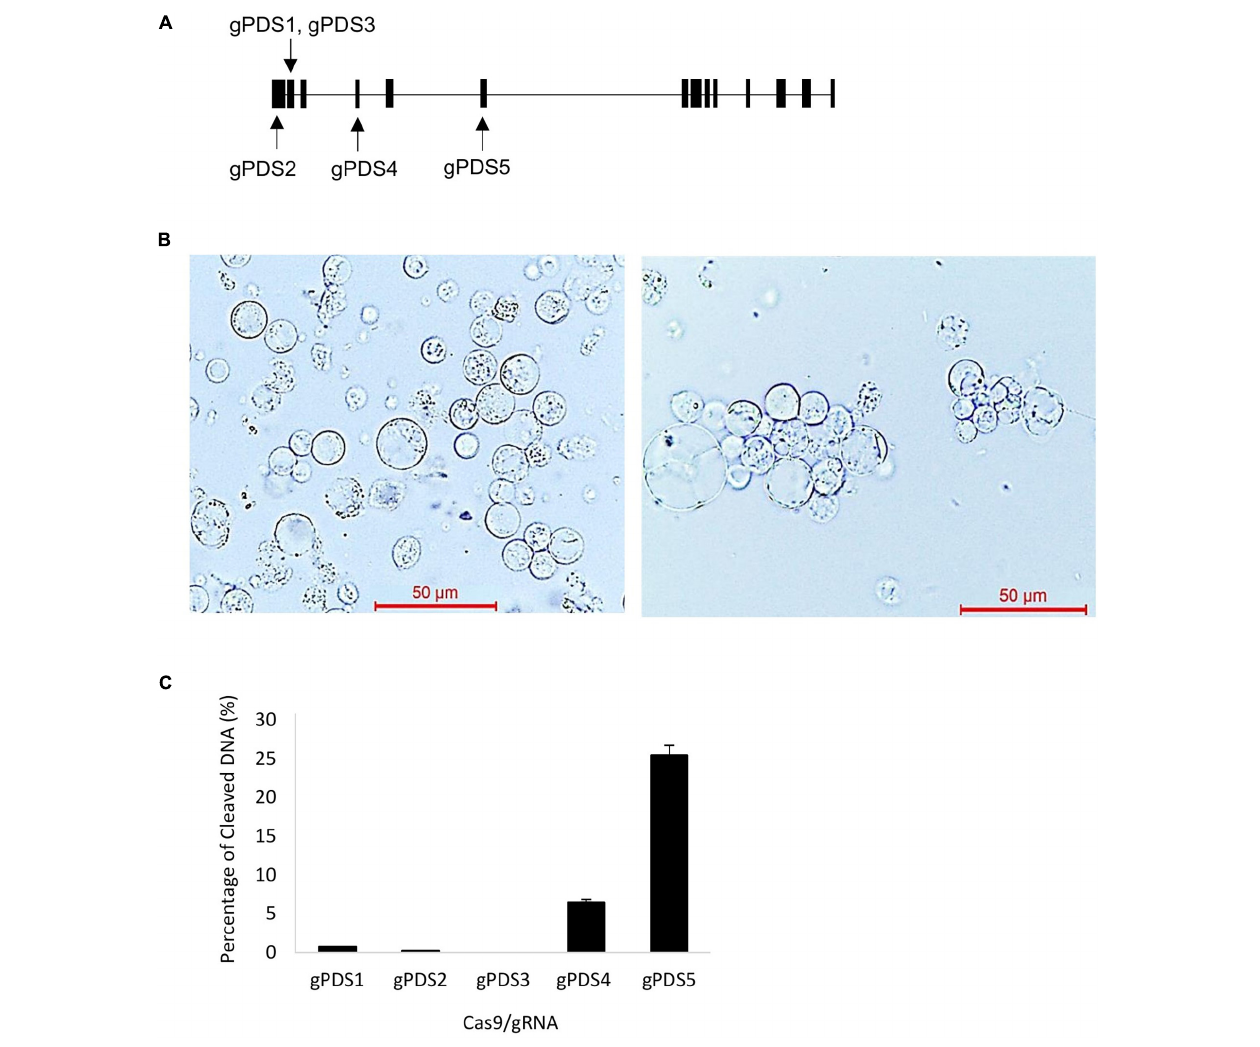
FIGURE 1 | Efficiency testing of clustered regularly interspaced short palindromic repeat (CRISPR)/CRISPR-associated protein 9 (Cas9) and guide RNA (gRNA) activity using electro-transfection in oil palm protoplasts. (A) Schematic map of gRNA target site in phytoene desaturase ( EgPDS) gene. (B) Oil palm protoplast before (left) and protoplast agglutination after (right) electro-transfection with Cas9/gRNA. (C) Cleavage efficiency of Cas9/gRNA in oil palm protoplast following electro-transfection. Data are average values ± SE from four independent